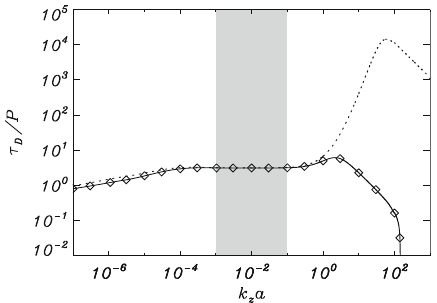
Fig. 75 Ratio of the damping time to the period of the kink mode as a function of k z a in an infinitely long thread with a = 100 km and l / a = 0 . 2. The different line styles represent the results for a partially ionised thread with ˜ μ p = 0 . 8 and considering all the terms in the induction equation (solid line), for a partially ionised thread with ˜ μ p = 0 . 8 and neglecting Hall’s term (symbols) and for a fully ionised thread (dotted line). Image reproduced with permission from Soler et al. (2009d), copyright by